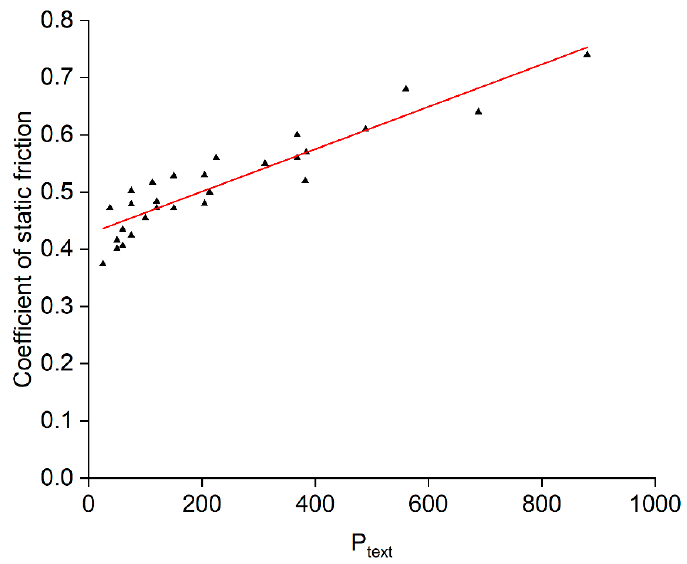
Figure 13. The processing window when using both 20 W and 200 W lasers.